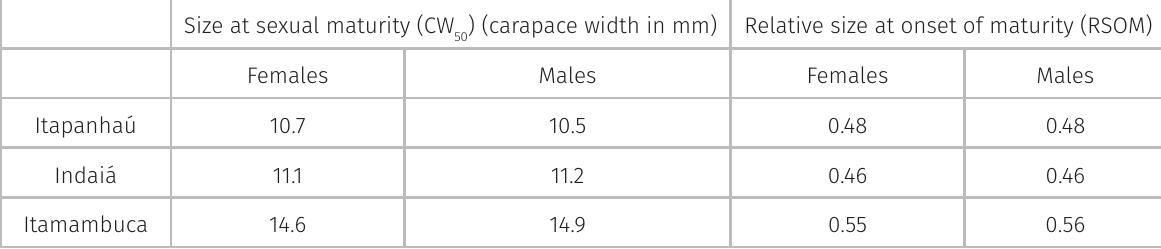
Table IV. Sizes at which 50% (CW ) of females and males of Minuca vocator of each population (Itapanhaú, Indaiá, 50 and Itamambuca) reached sexual maturity and their respective relative size at onset of maturity